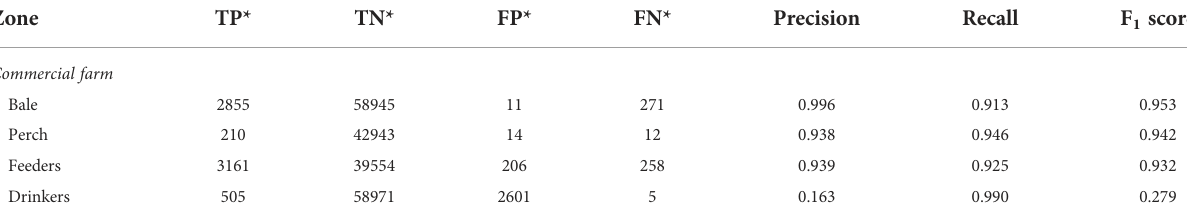
TABLE 3 Resource use monitoring quality for the commercial farm based on Mask R-CNN segmentation